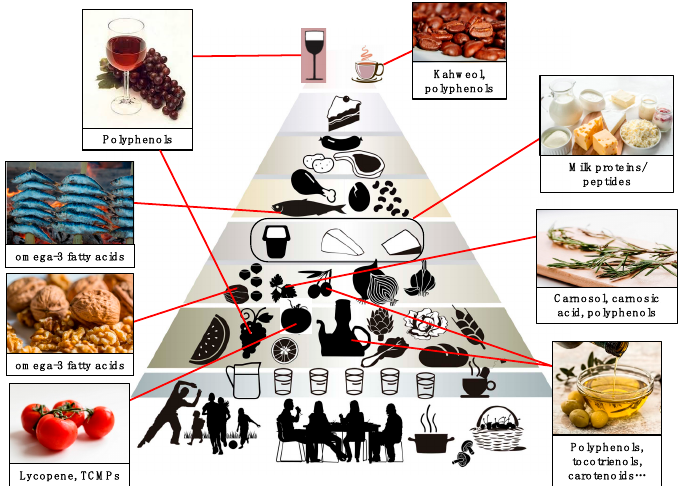
Figure 4. The Mediterranean diet (MD) as a source of antiangiogenic compounds with potential use in cancer angioprevention. Schematic representation of the MD pyramid (modified from Fundación Dieta Mediterránea [27]), showing the main components that could have a role in angioprevention due to their content in antiangiogenic bioactive compounds.